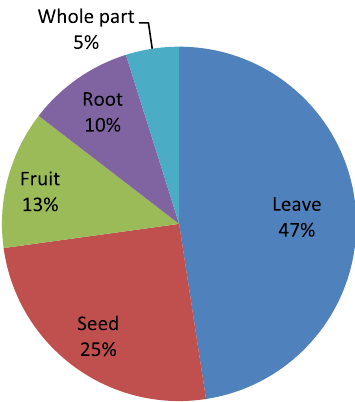
Fig. 3 Parts of medicinal plants used by the local people in the study